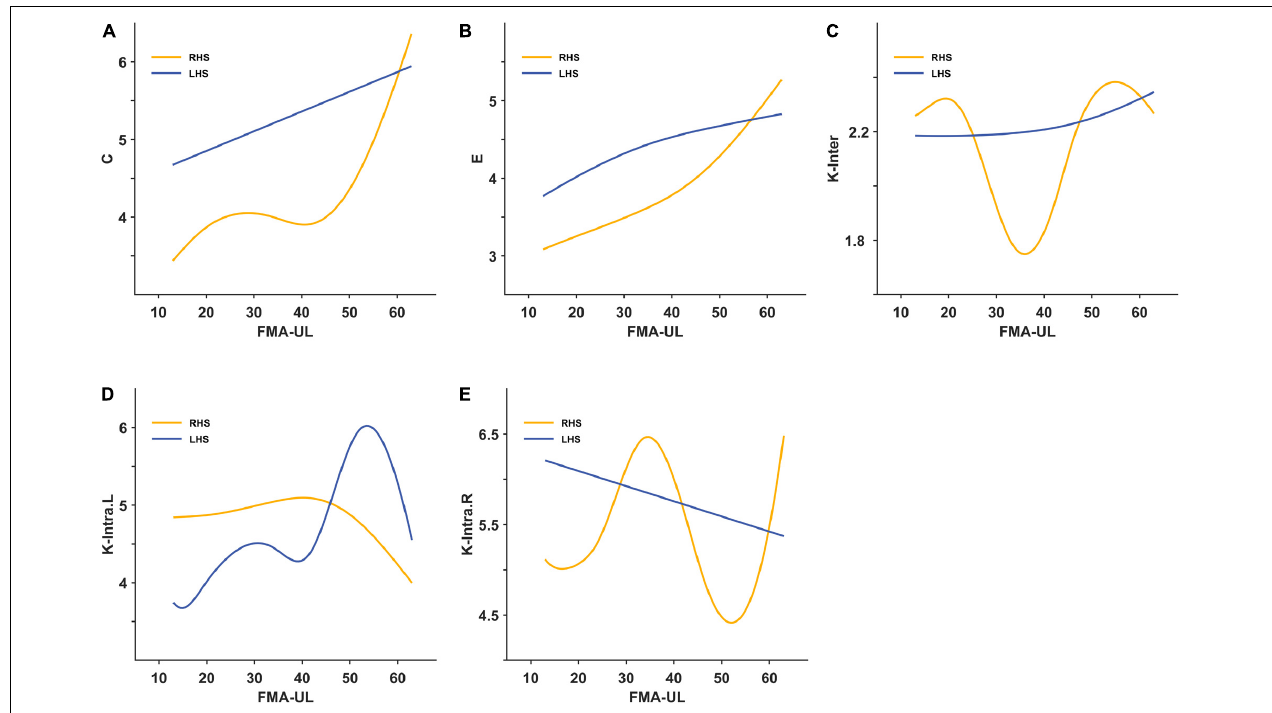
FIGURE 5 | The smooth curve fitting between area under curves (AUCs) of the brain network indicators and Fugl-Meyer Assessment of upper limbs (FMA-UL). (A) For the average weighted clustering coefficient; (B) for the global efficiency; (C) for the inter-density; (D) for the intra-density of left hemisphere; (E) for the intra-density of right